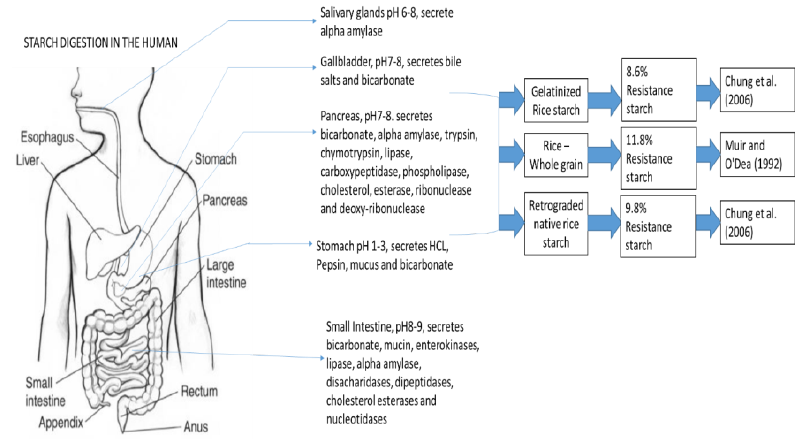
Figure 2. Digestive enzymes secreted by different organs contribute to the digestion of foods in humans. The digestive system, an extension of the environment into the body, also stores mucus, acid, bicarbonate, and salts to enable hydrolysis of foods and absorption of nutrients essential for